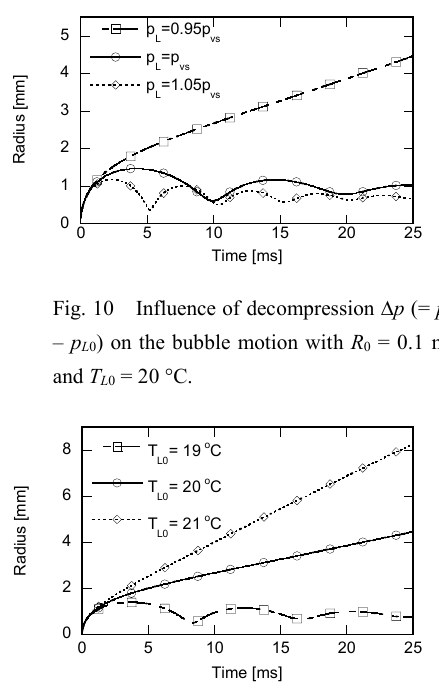
Fig. 11 Influence of initial temperature T L 0 on the growth of the bubble with R 0 = 0.1mm and p L ∞ = 0.95 p vs ( T L 0